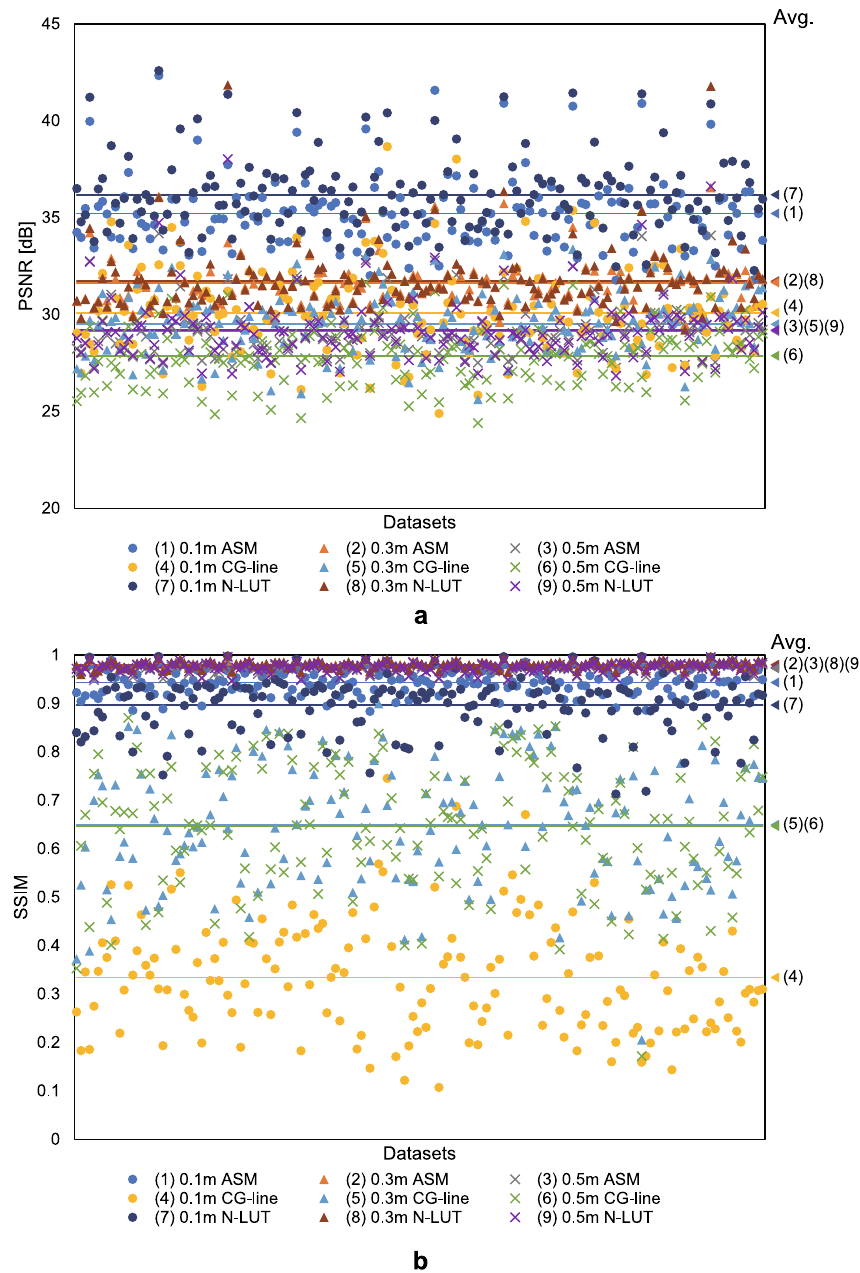
Figure 6. Results of image-quality evaluation with the different datasets. ( a ) PSNR. ( b )